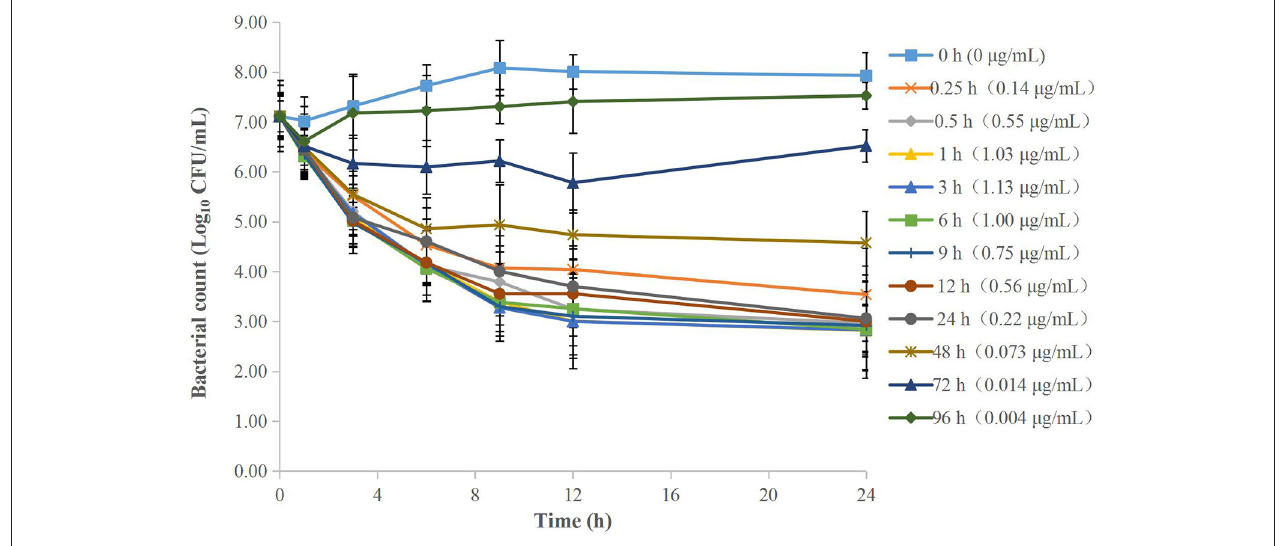
FIGURE 5 | Ex vivo time-kill curves of cefquinome against A. pleuropneumoniae in TCF before and after intramuscular administration. Values are the mean ± standard deviation ( n = 6).